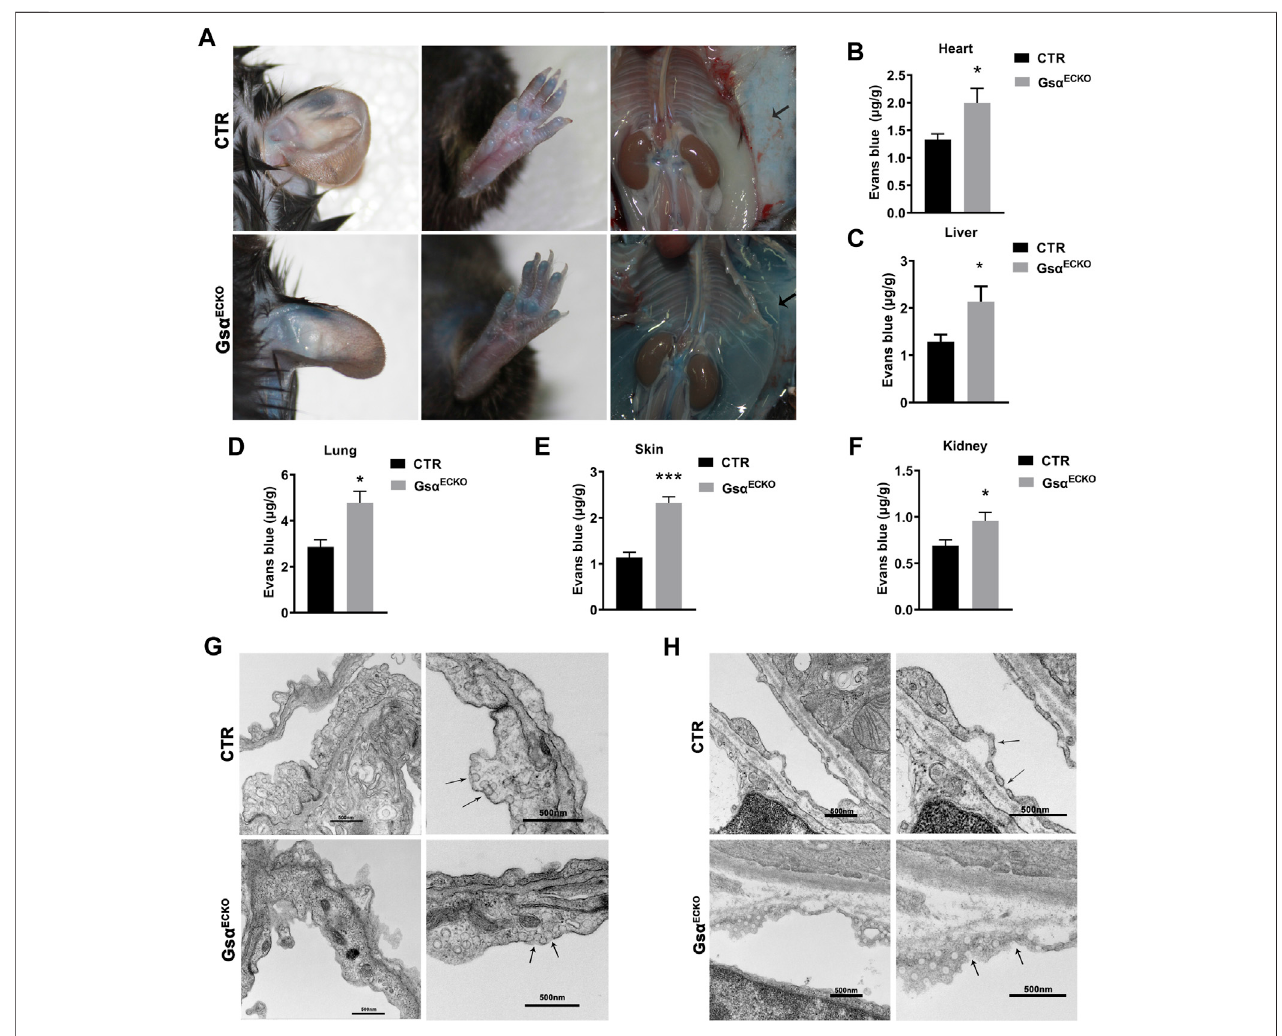
FIGURE 2 | Loss of endothelial Gs α increased microvascular permeability. (A) Representative gross images of CTR and Gs α ECKO mice after EB dye injection. The black arrow indicated EB dye exudation in Gs α ECKO mice. (B – F) Quanti fi cation of EB dye extravasation of heart, liver, lung, skin, and kidney. n = 5 per group. (G,H) Transmission electron micrographs of capillaries from lung and kidney of CTR and Gs α ECKO mice. The arrowhead indicated the absence of diaphragms. Scale bar, 50 nm. Data are shown as mean ± SEM. * p < 0.05; ** p < 0.01; *** p < 0.001; **** p < 0.0001 between 2 indicated groups by 2-tailed Student t-test.